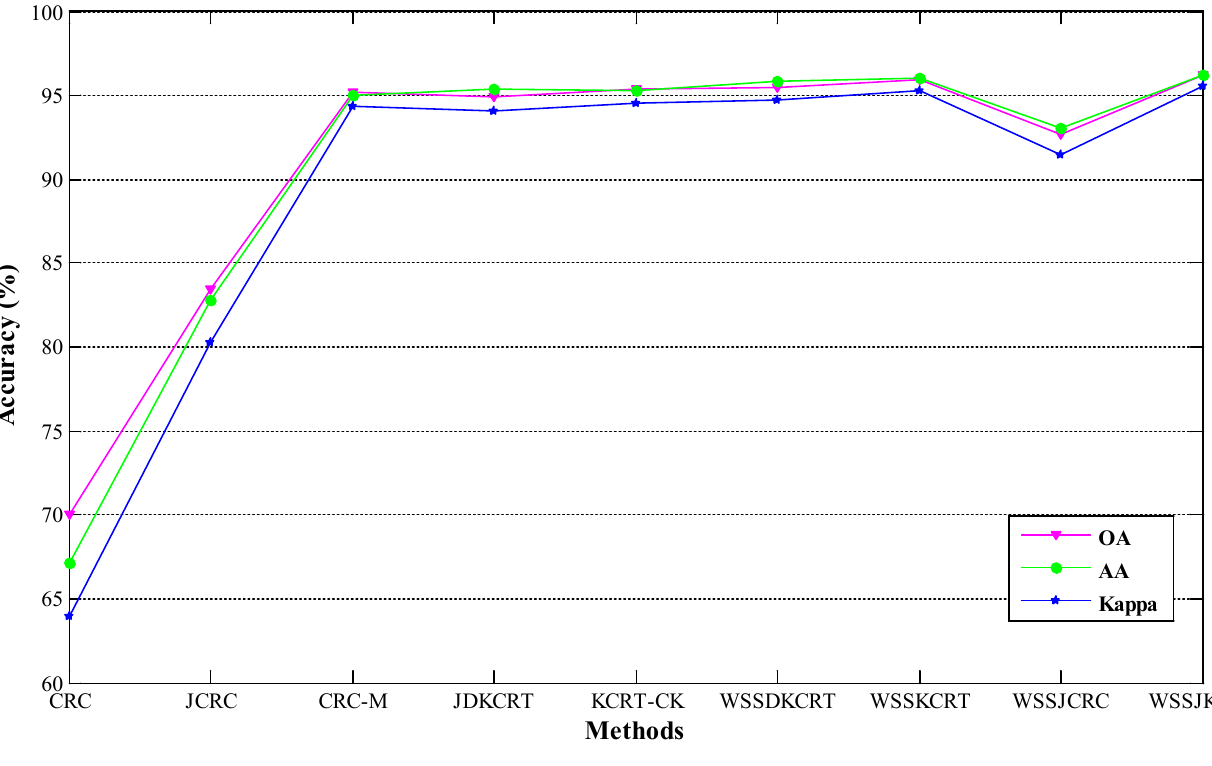
Figure 10. The OA, AA, and Kappa values for different methods on the Indian Pines scene.